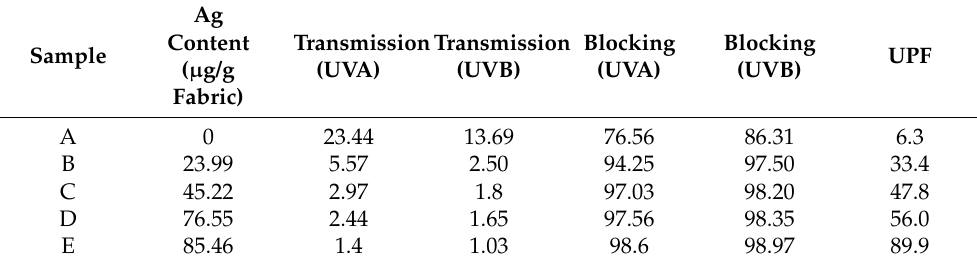
Table 2. UPF Values and Blocking for UVA (290–315 nm) and UVB (315–400 nm) for pristine cotton fabric and different samples of Cotton Fabrics with in situ AgNP synthesis (2 mM AgNO 3 , 20% Leaf Azadirachta indica leaf extract, Mixing Ratio 9:1, pH 7.1. A. No treatment B. No mercerization, Room temperature synthesis. C No mercerization, hydrothermal synthesis. D Mercerization, Room temperature synthesis. E Mercerization, Hydrothermal synthesis.